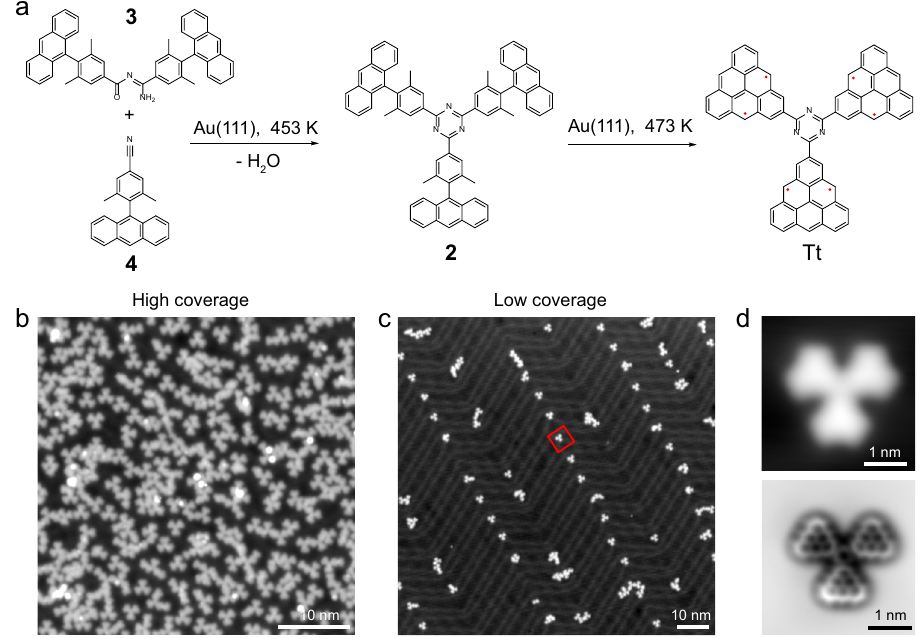
Fig. 3 Synthesis and chemical structure characterization of triangulene trimers Tt. a On-surface synthetic routs toward structure Tt. b , c Overview STM images after annealing precursors 3 and 4 on Au(111) at 453 K at high and low coverages. d Zoom-in STM and AFM images of Tt on Au(111) with CO- functionalized tungsten tip. Setpoint: V = 300 mV, I = 30 pA; Δ z = 0.02